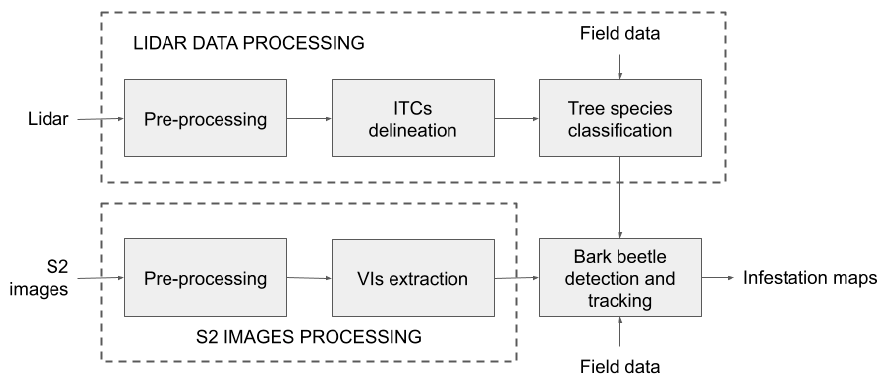
Figure 2. Architecture of the system used to detect bark beetle attack.